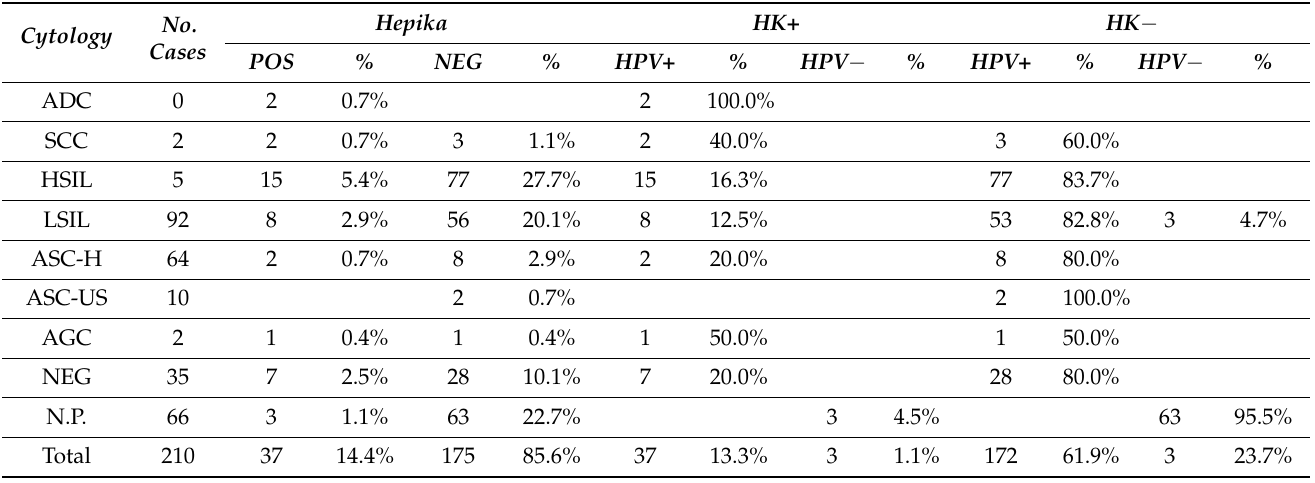
Table 3. Hepika test results per cytology and human papillomavirus (HPV) DNA test.